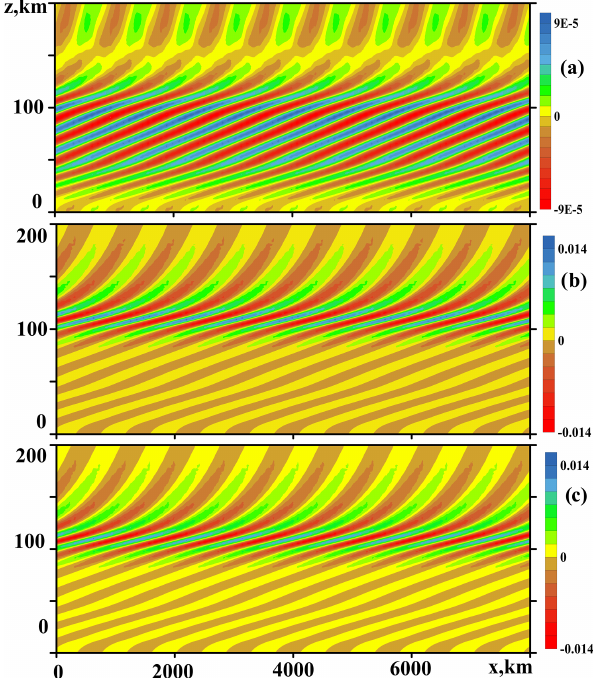
Figure 6. AGW vertical velocity fields at times t ≈ 30h (a) , t ≈ 70h (b) and t ≈ 110h (c) for the steep rate of activating and deactivating the wave source (Eq. 5) with c x = 50ms − 1 and W 0 = 0.01mms − 1 .